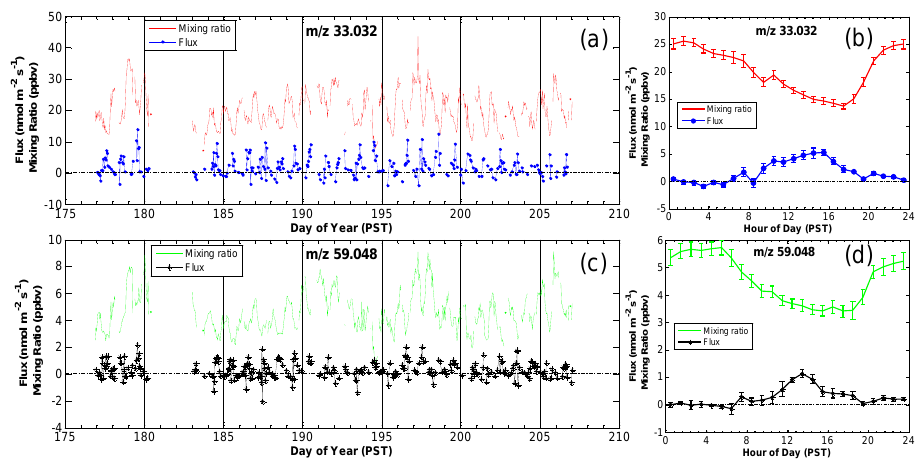
Fig. 4. Time series (26 June to 26 July 2012) of mixing ratios and fluxes for (a) m/z 33.032(methanol) and (c) m/z 59.048 (acetone) from PTR-TOF-MS measurements. Hourly averaged diurnal cycles of mixing ratios and fluxes of m/z 33.032 and m/z 59.048 are shown in (b) and (d), respectively. Error bars in (b) and (d) denote standard errors of all measurements at the respective hour of the day.